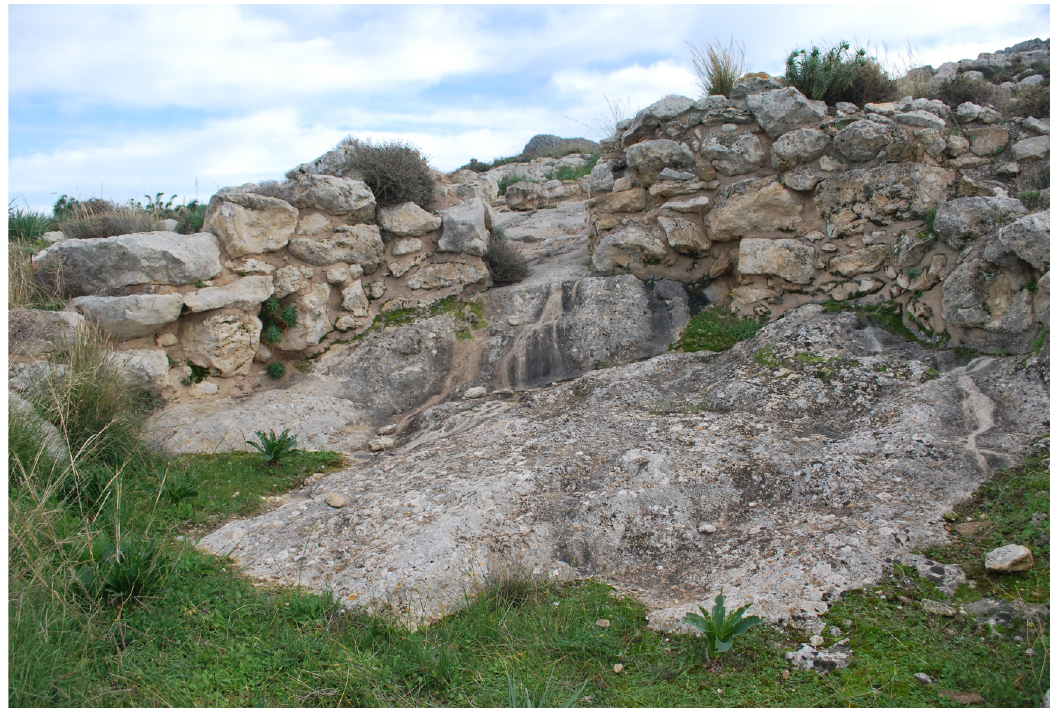
Figure 5. The floor and the doorway of the circular chamber of Tholos A, seen from the west. Note the rising level of the bedrock towards the east, where the annex rooms (not visible on the photograph) are located.